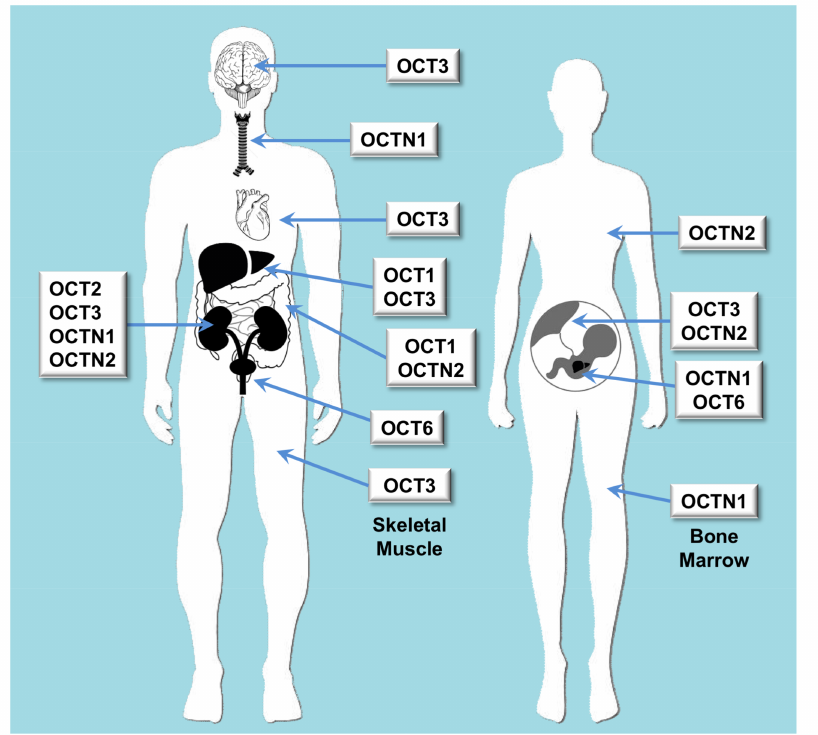
Figure 1. Scheme of the main features regarding organ distribution of proteins belonging to the SLC22 family of transporters able to transport organic cations. OCT: organic cation transporter; OCTN: organic carnitine